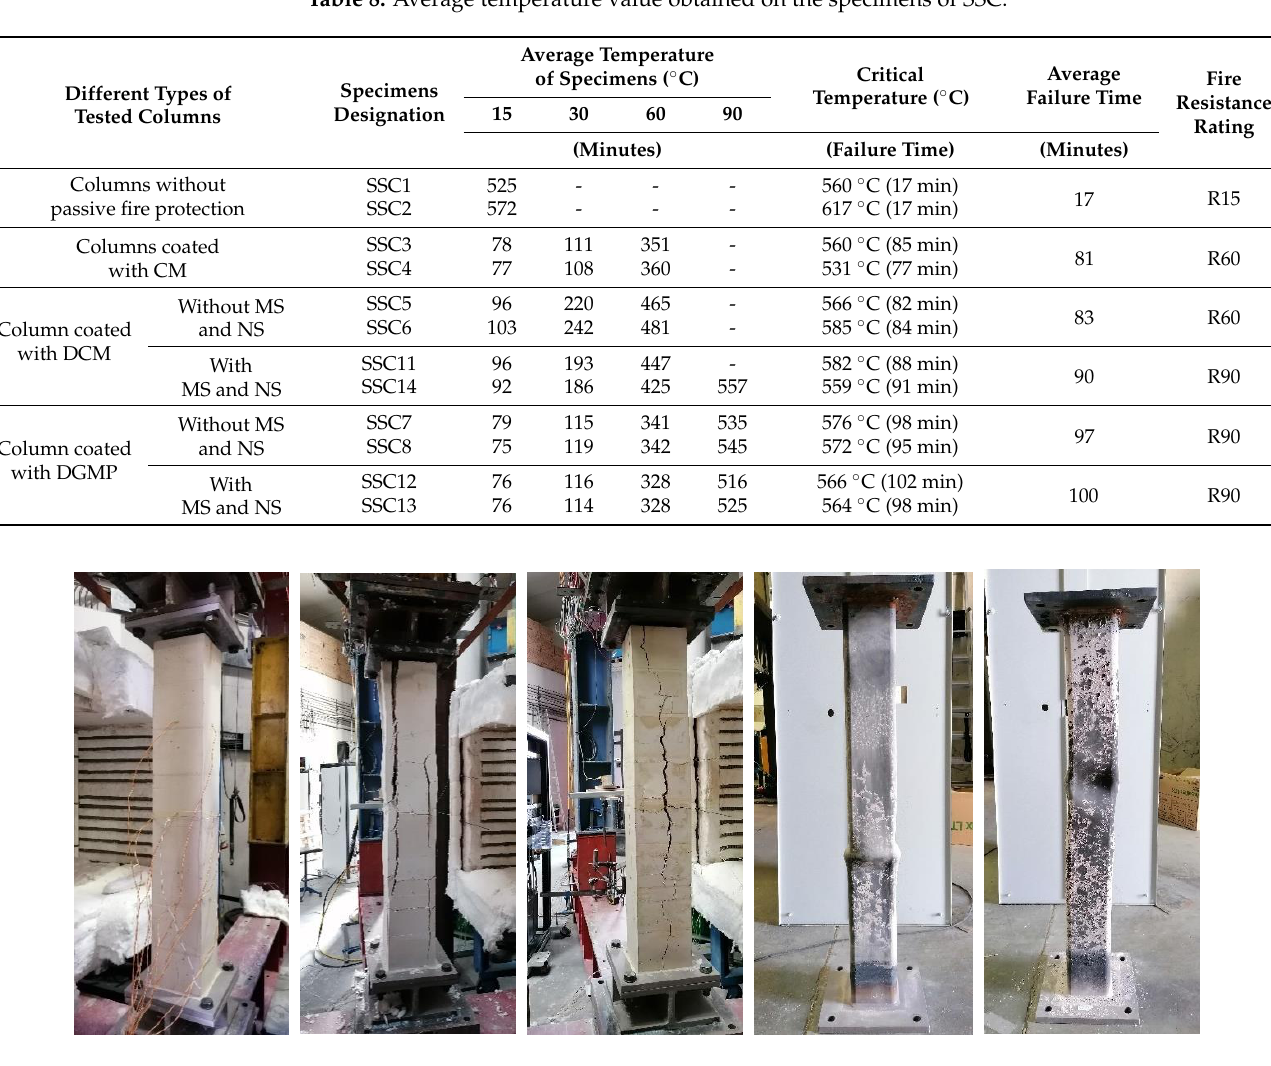
Figure 14. Photos of the specimens of SSC before and after tested, as an example.